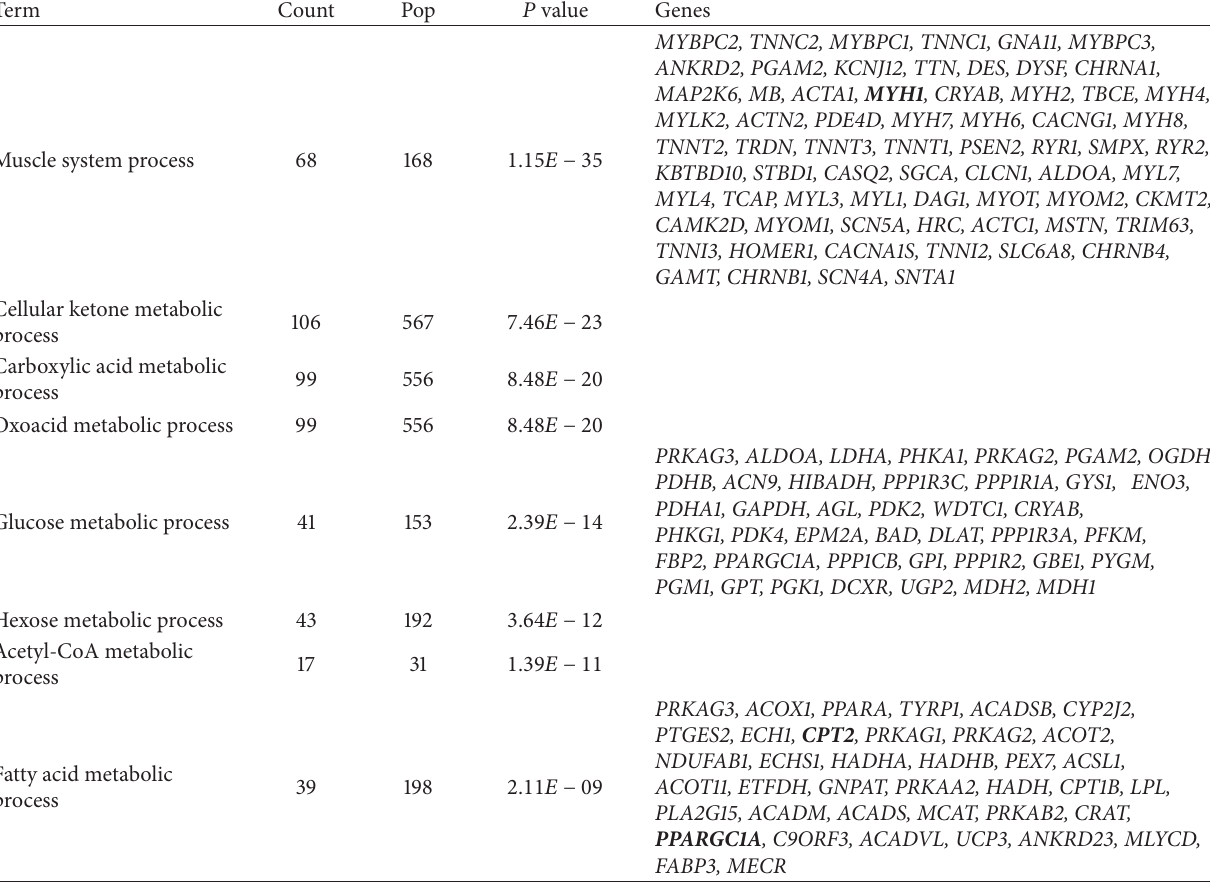
Table 1: GO enrichment of genes coexpressed with MRCs only in normal tissue transcriptome.